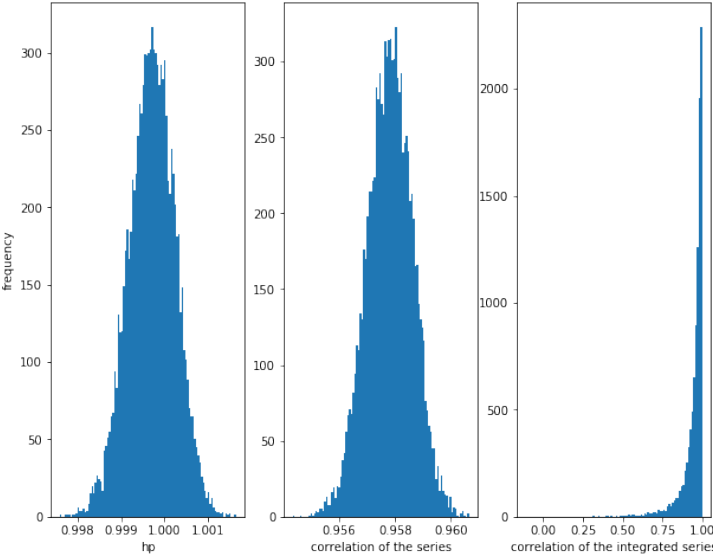
Figure 1. Histogram of the relationships in correlated series with σ = 0.3. The strong correlation is detected by the three methods, though the correlation of the integrated series show some